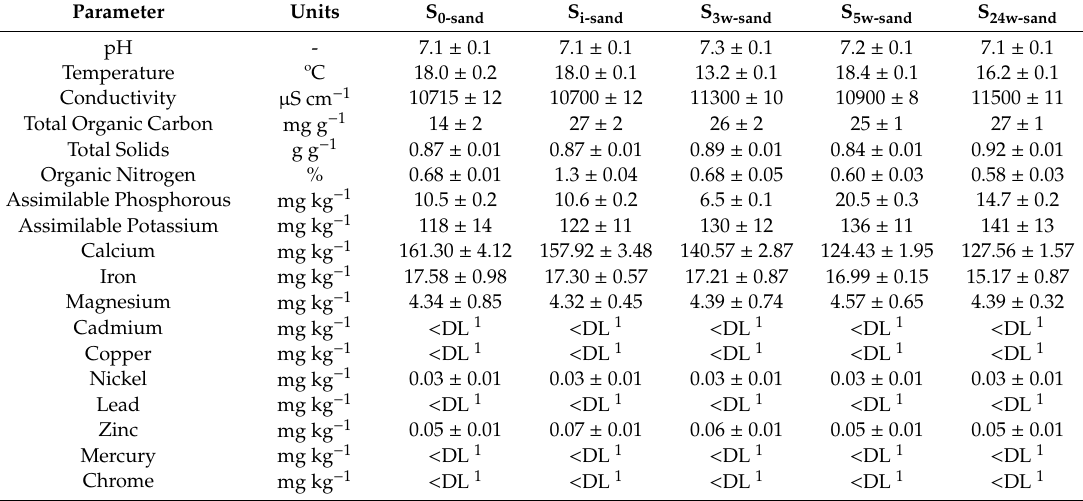
Table 7. Evolution of physical and chemical parameters of sandy soil amended with sewage